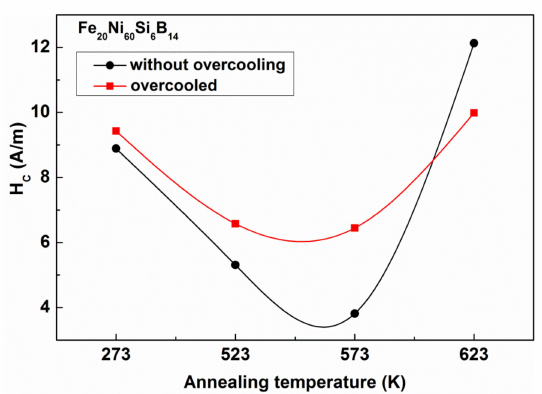
Figure 22. Comparison of the coercivity ( H c ) for LN treated and as-received samples after isothermal relaxation caused by heat treatments lasting 1 h at various temperatures. Adopted from [96], with permission from Springer Nature, 1969.